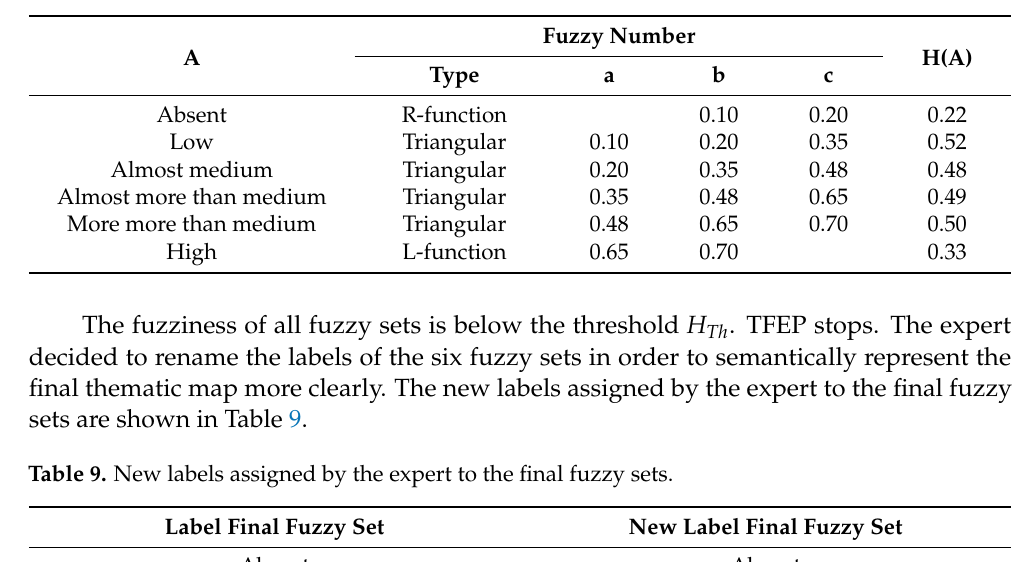
Table 8. Fuzzy sets of the fuzzy partition in Figure 14 and their fuzziness.